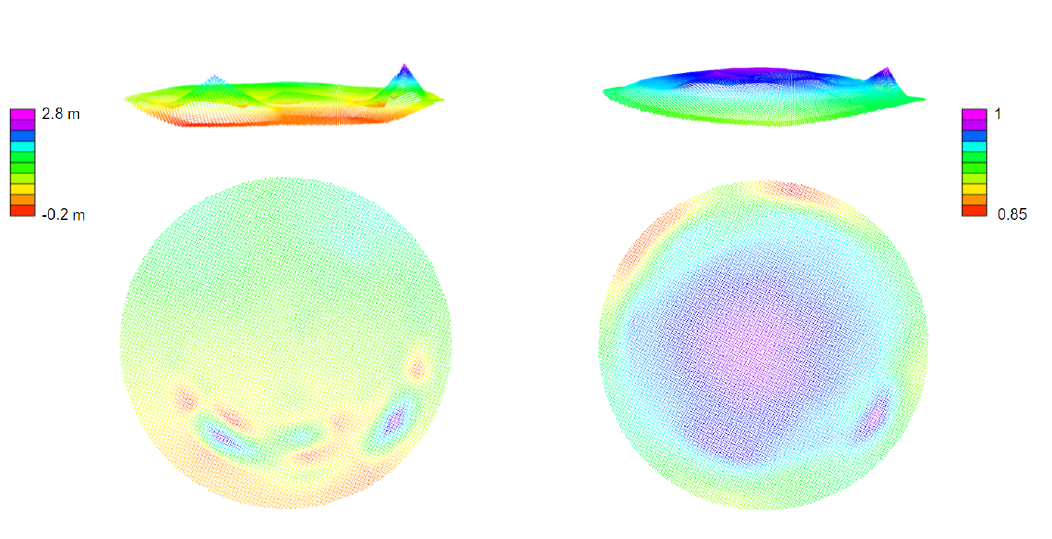
Figure 11. Lateral ( top ) and aerial views ( bottom ) of the FEM ( left ) and FRM ( right ) associated with the filtered 3D point cloud of Figure